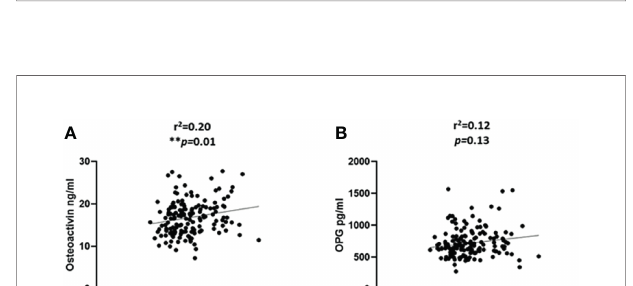
FIGURE 2 | Correlation analysis between irisin and various molecules associated with bone remodeling. (A) Osteoactivin, (B) Osteoprotegerin (OPG), (C) Osteonectin (SPARC), (D) Syndecan-4 levels in plasma. Performed on the non-diabetic individuals age adjusted. Irisin level in plasma was determined using enzyme linked immunosorbent assay (ELISA), a customized multiplex bone panel was used to assess the level of various osteogenic molecules. Diabetes was de fi ned by fasting plasma glucose ≥ 126mg/L (7mmol/L). Spearman correlation coef fi cient was used to determine the association of irisin with the different osteogenic factors. Statistical assessment was 2-sided and considered statistically signi fi cant at **p ≤